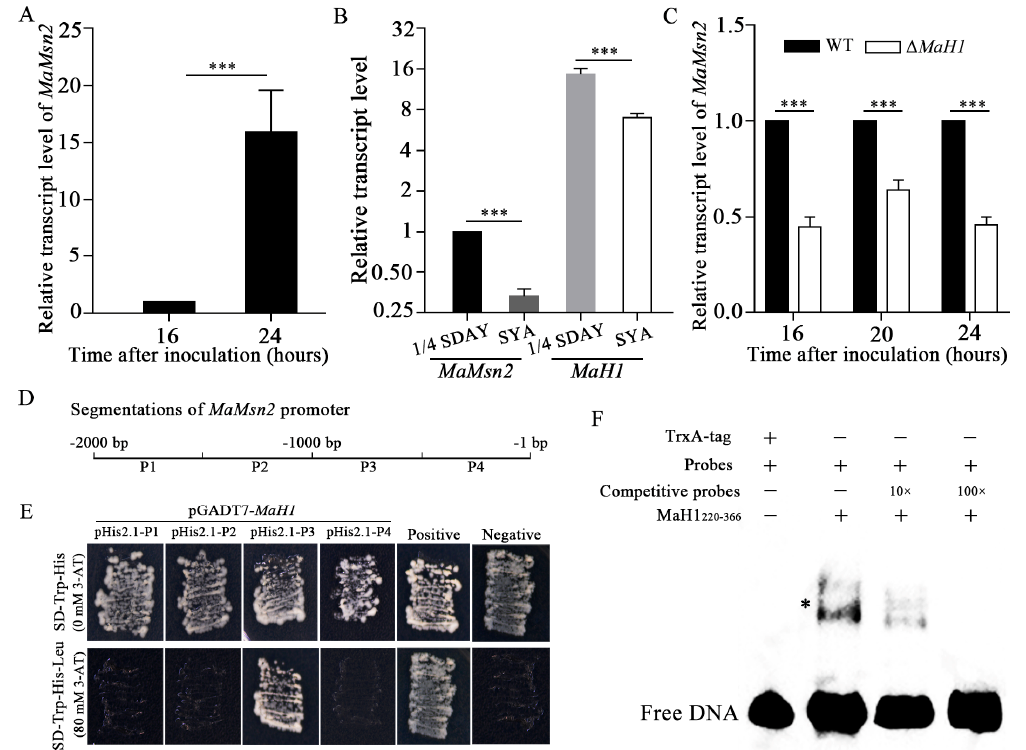
Figure 5. Interaction analysis between MaH1 and MaMsn2 . ( A ) Transcription level of MaMsn2 in WT on 1/4 SDAY at 16 h and 24 h. The MaMsn2 transcript level at 16 h was set to 1. ( t -test, ***: p < 0.001). ( B ) Transcription levels of MaH1 and MaMsn2 in WT on 1/4 SDAY and SYA at 24 h. The MaMsn2 transcript level on 1/4 SDAY was set to 1. ( t -test, ***: p < 0.001) ( C ) Transcription levels of MaMsn2 in WT and Δ MaH1 on 1/4 SDAY at 16 h, 20 h and 24 h. ( t -test, ***: p < 0.001). ( D ) Different regions of MaMsn2 promoters for binding analysis with MaH1 by Y1H. ( E ) Y1H assay between MaH1 and different MaMsn2 promoter regions. ( F ) EMSA assay with purified trxA-MaH1 220 − 366 and probe labeled by biotin. The competitive probe was unlabeled and 10 to 100 fold excess compared to the labeled probe. +: probe or protein added, –: probe or protein not added. Asterisk indicates the position of shifted band.